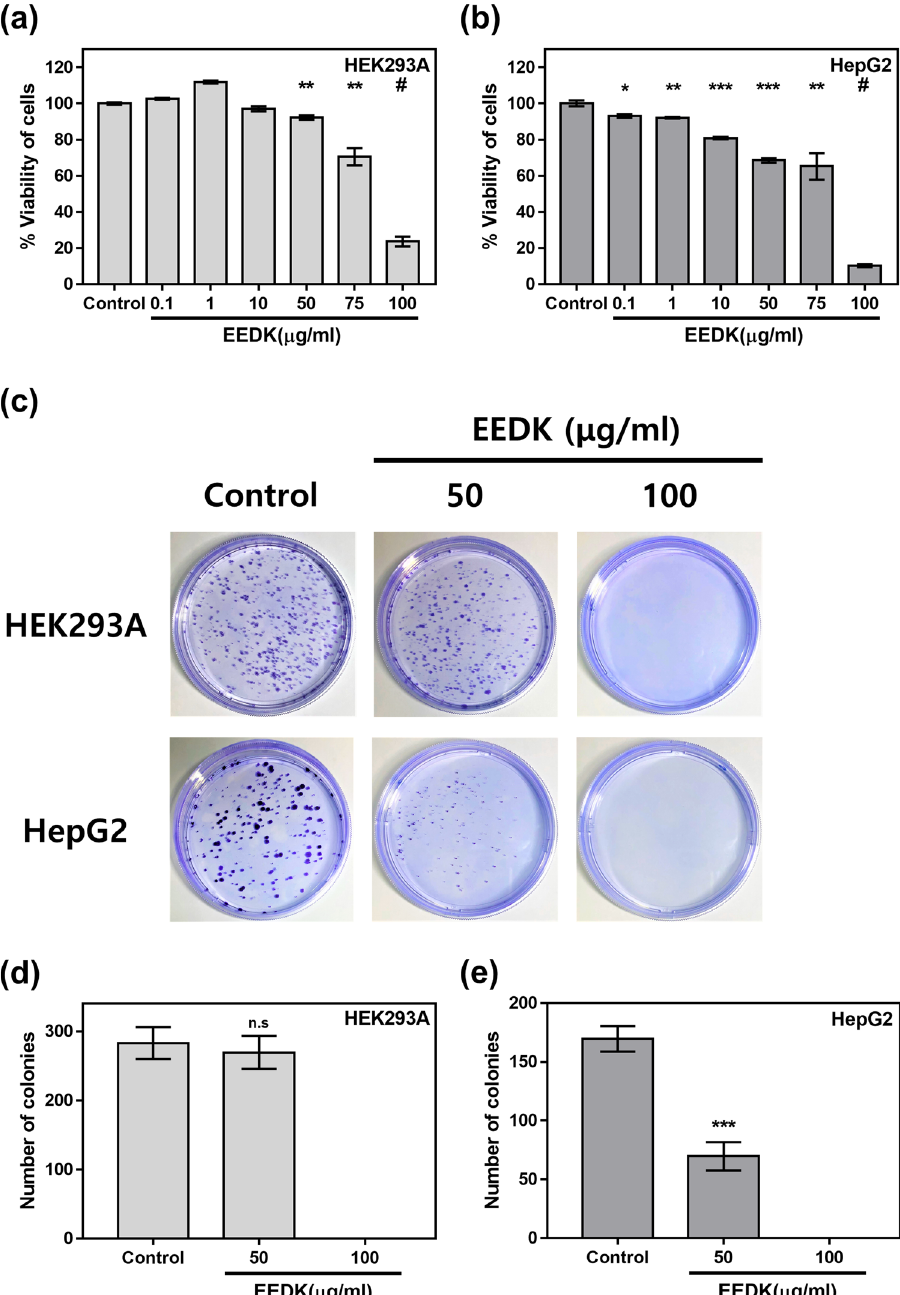
Figure 1. The effects of EEDK on cell death and proliferation. ( a , b ) viability of ( a ) HEK293A and ( b ) HepG2 cells exposed to control (0.5% (v/v) DMSO) and EEDK (0.1 to 100 μg/mL) for 24 h, as measured using viability assays. The bar graphs describe mean values of cell viability with error bars indicating the Standard error of the mean(S.E.M) (n = 3, * P < 0.05, ** P < 0.01, *** P < 0.001, and # P < 0.0001, Student t-test). Absorbance values of solubilized formazan product were measured using the Glomax Multi + Microplate Multi Reader (9301- 010. Promega, USA). ( c ) Clonogenic assay images of HEK293A and HepG2 cells exposed to control (0.5% (v/v) DMSO) and EEDK (50 and 100 μg/mL) for 30 h. The medium was replaced with growth medium. ( d , e ) The bar graphs represent the mean number of colonies, with error bars indicating the S.E.M (n = 3, n.s > 0.05, *** P < 0.001, student t-test). Colony pixel is > 20, circularity is 0.2–1.0. Quantification of cell colonies was performed using the ImageJ